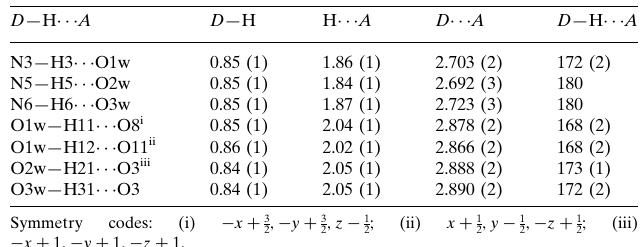
Hydrogen-bond geometry (A˚ , (cid:4)